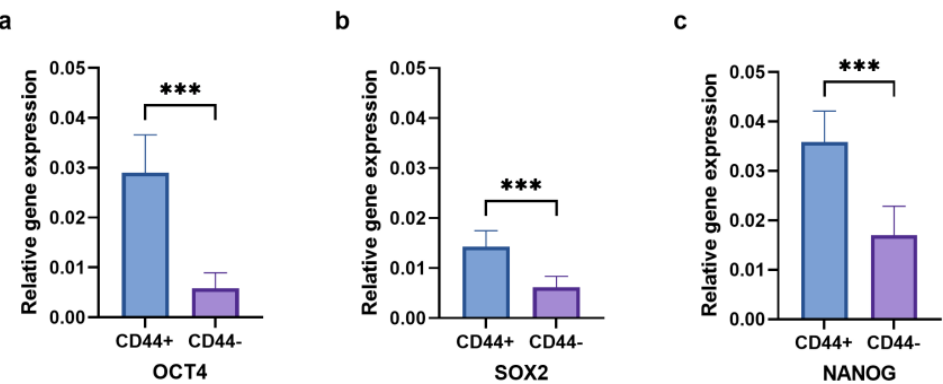
Figure 9. The expression of OCT4 ( a ), SOX2 ( b ), and NANOG ( c ) in CD44 + and CD44 − cells. CD44 + — CD44-positive cells, CD44 − — CD44-negative cells, and *** p ≤ 0 .001.